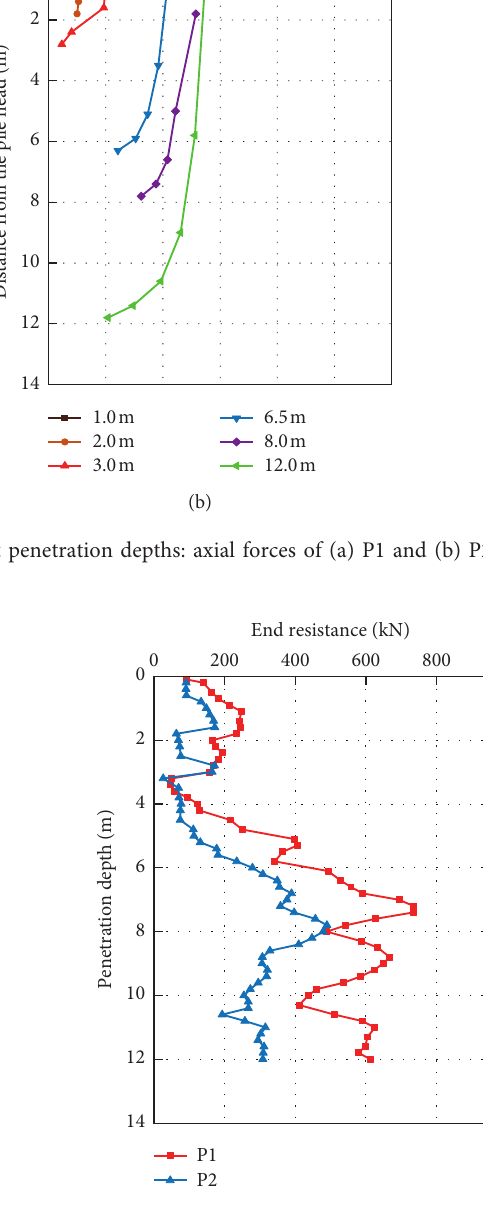
Figure 5: End resistance versus penetration